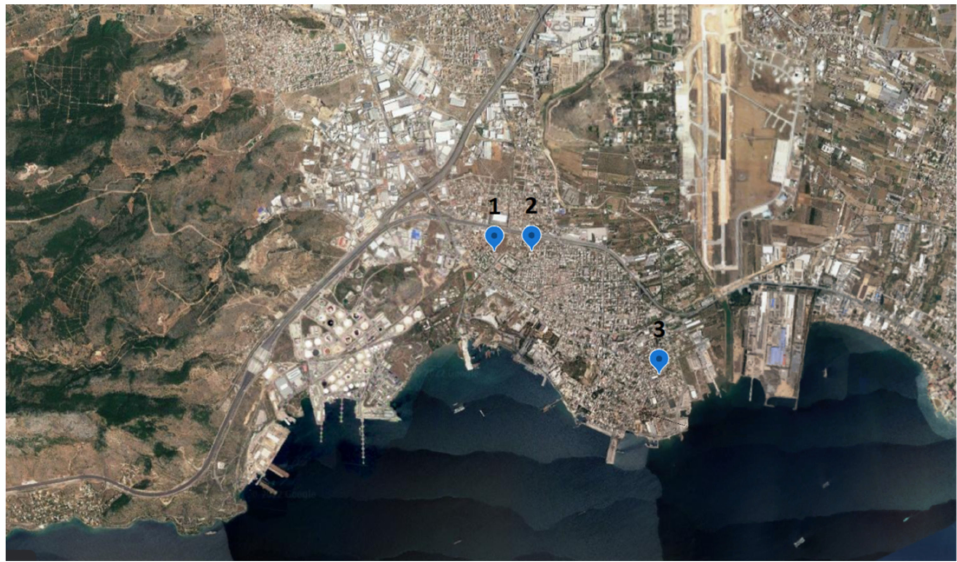
Figure 2. Spatial representation of the sampling sites in the municipality of Elefsina (1, 2, 3, Source: Google